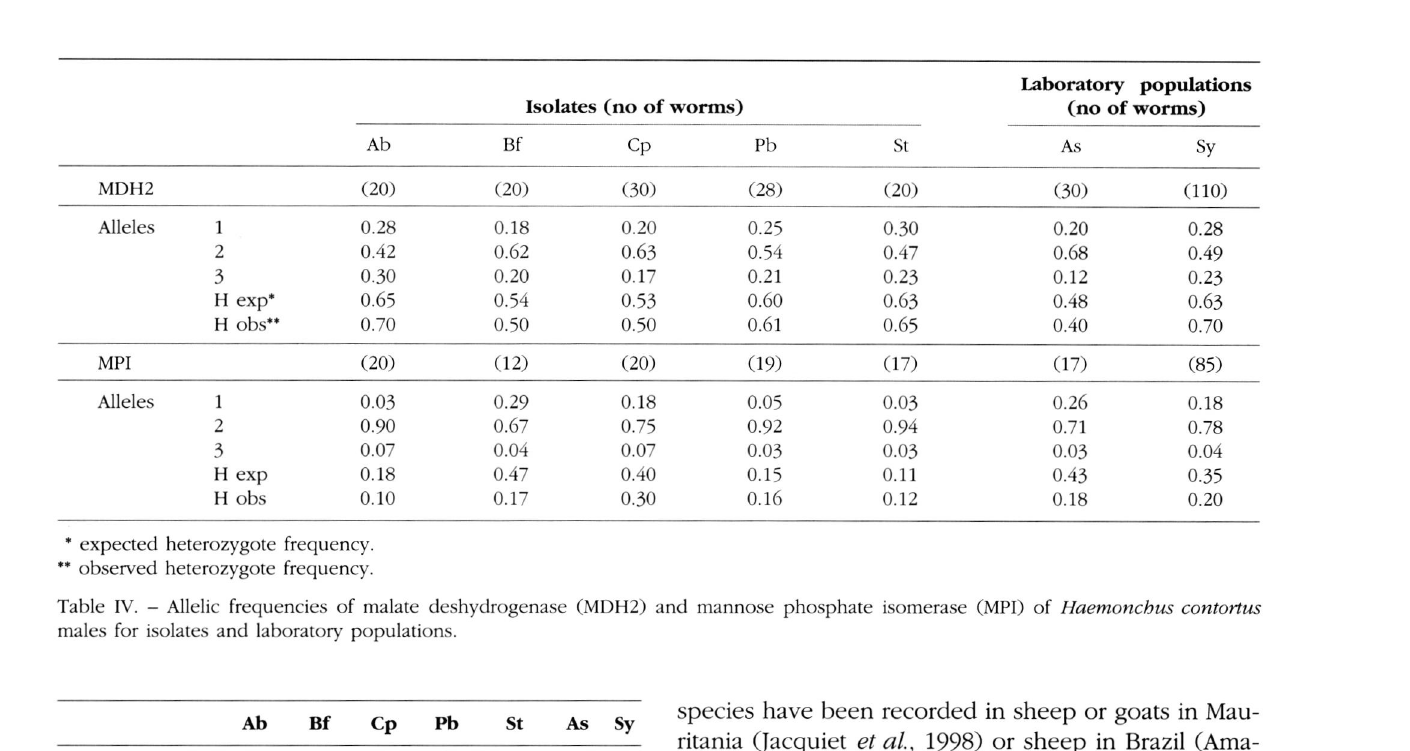
Table V. - Genetic differentiation (F st : non random mating between populations) between Haemonchus contortus isolates and labora tory populations.